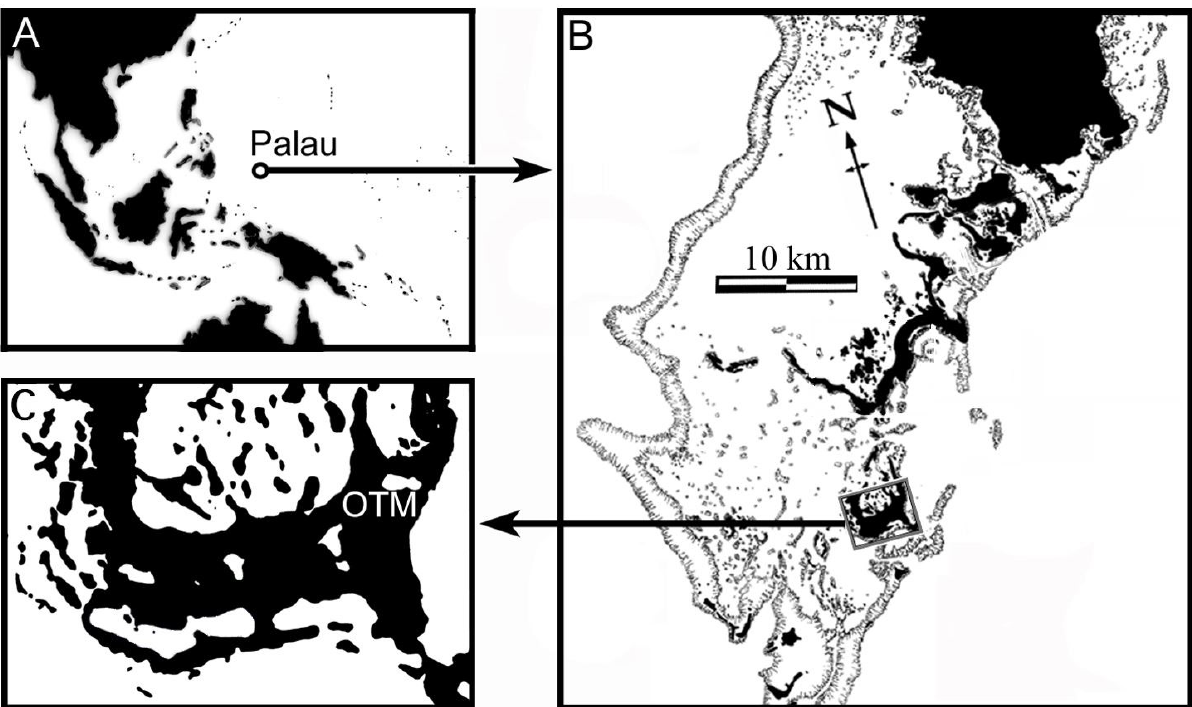
Figure 1. Map of the study regions and location. (A) The location of Palau within the Western Pacific. (B) The island on which Ongeim’l Tketau, Jellyfish Lake, is located within Palau. (C) The location of Jellyfish Lake, the eastern-most lake on the island of Mecherchar,